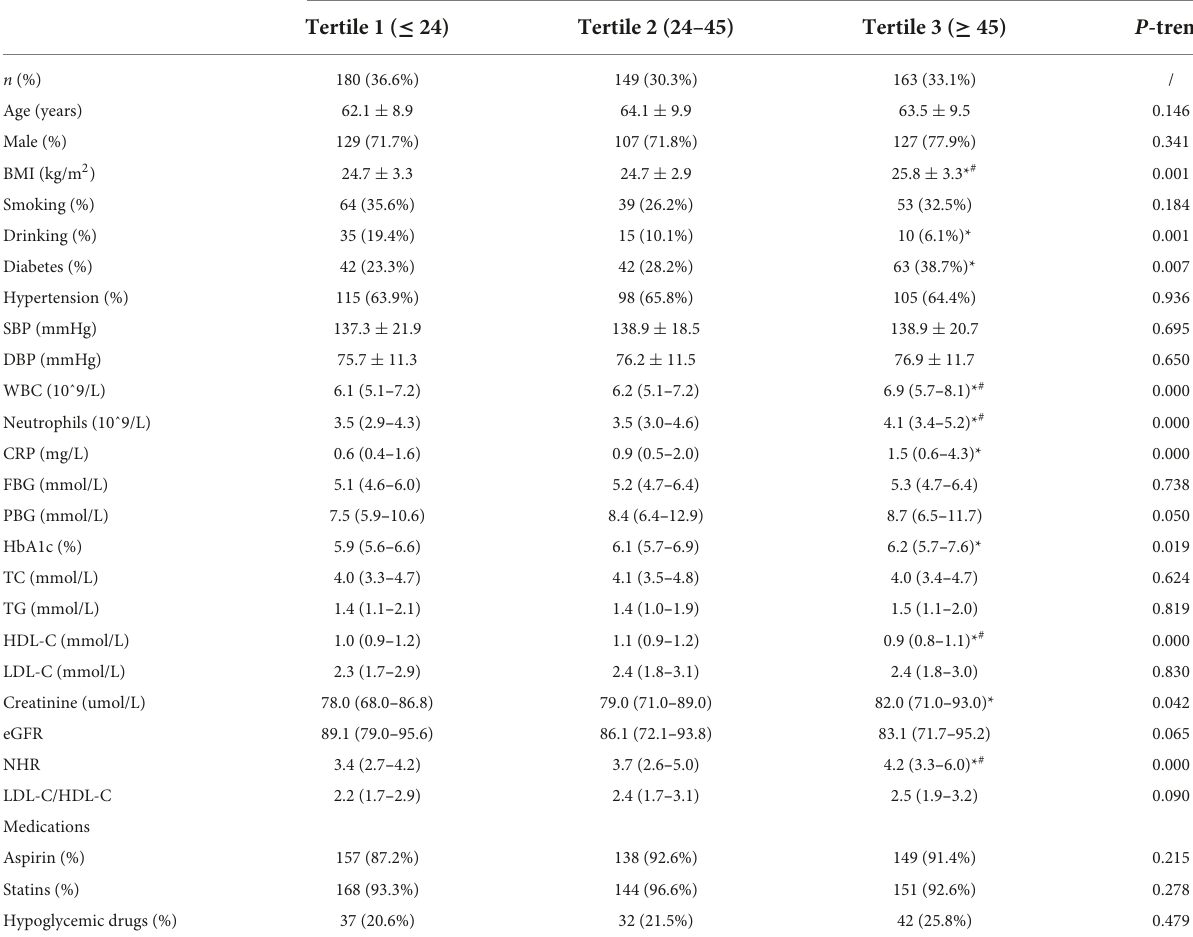
TABLE 3 Baseline characteristics of the participants stratified by tertiles of Gensini